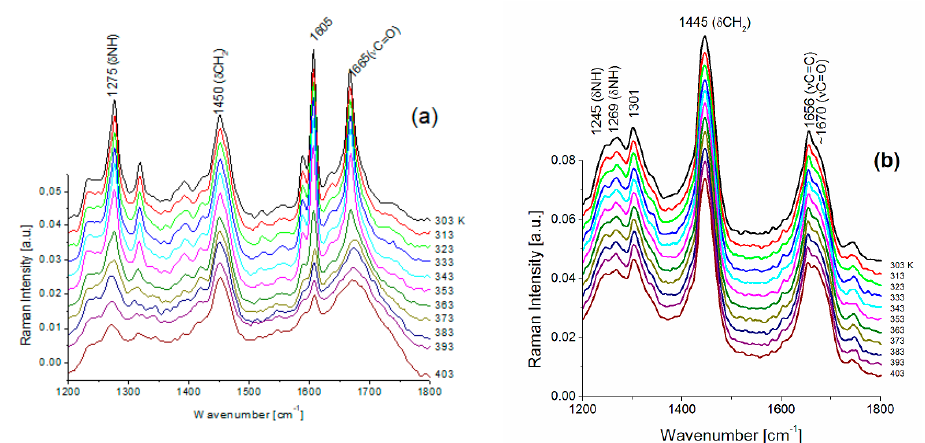
Figure 3. Temperature changes of Raman spectra for FS collagen ( a ) and BAT collagen ( b ) in the frequency range of amide III and amide I vibrations.